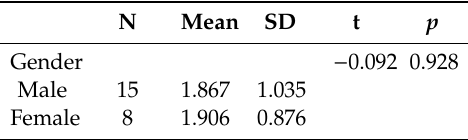
Table 5. t -test for hedonic quality–by gender.